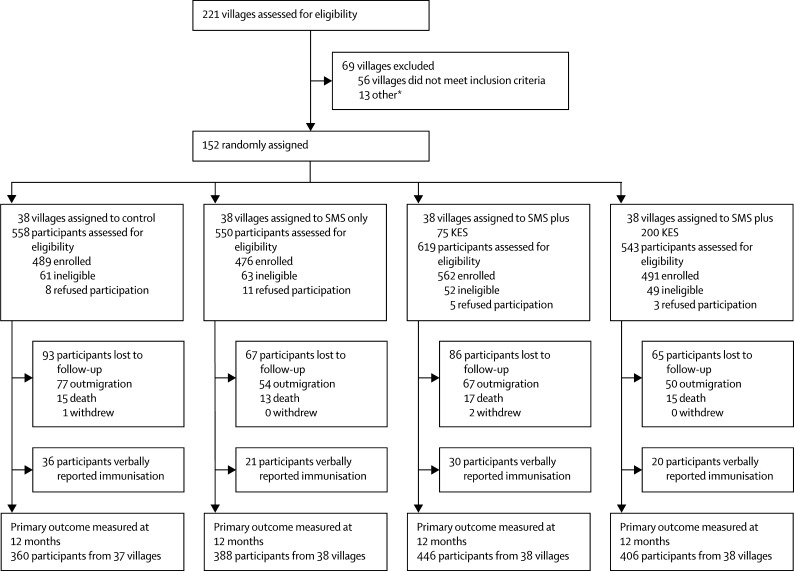
Trial profileSMS=short message service. KES=Kenyan Shilling. *Villages that immediately bordered villages that were excluded because of eligibility requirements.